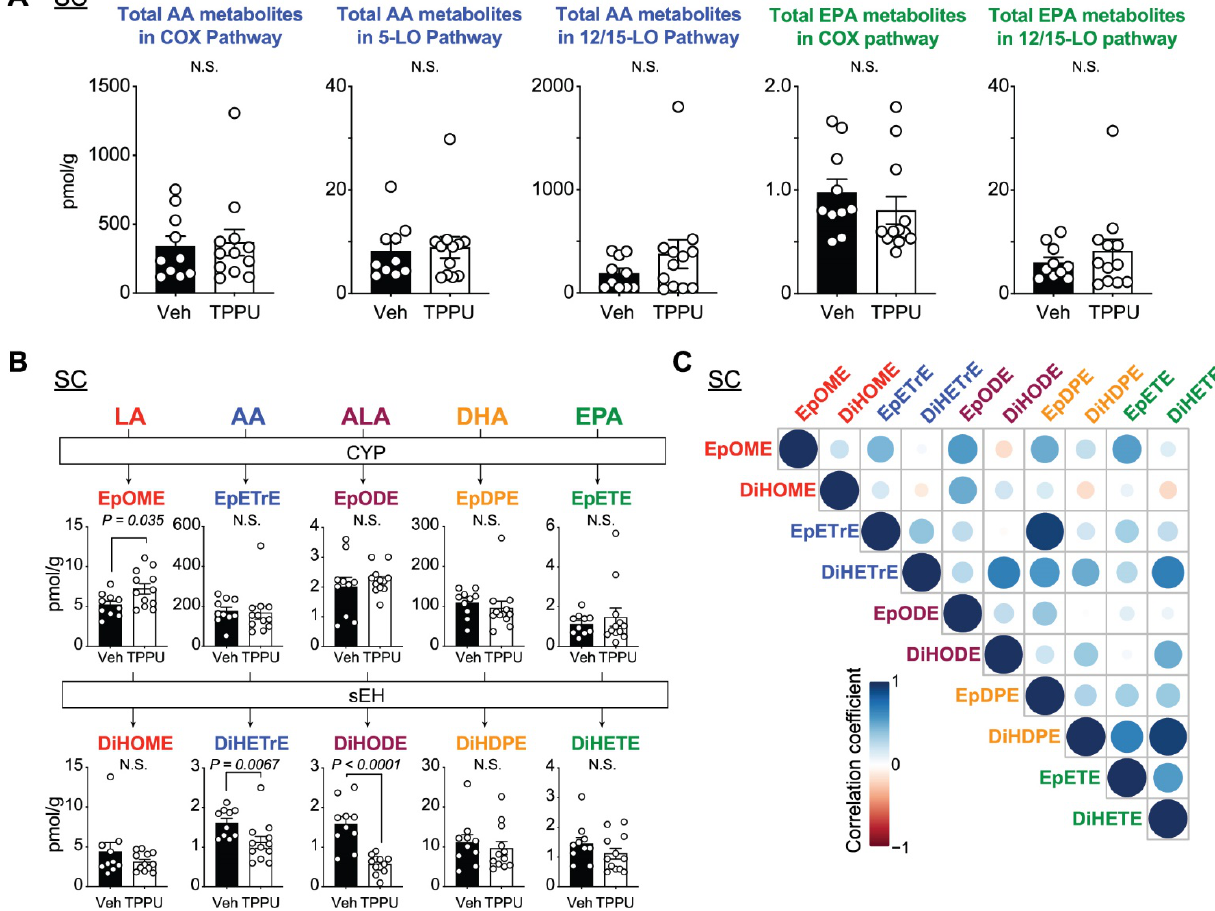
Figure 4. PUFA fluxes in EAE SCs. ( A ) Levels of AA and EPA metabolites in each pathway. ( B ) Levels of LA, AA, ALA, and EPA metabolites in the CYP-sEH pathway. ( C ) Correlation matrix of EpFAs and dihydroxy- FAs. P values were determined by t-test or Mann–Whitney U test. N.S., non-significant.